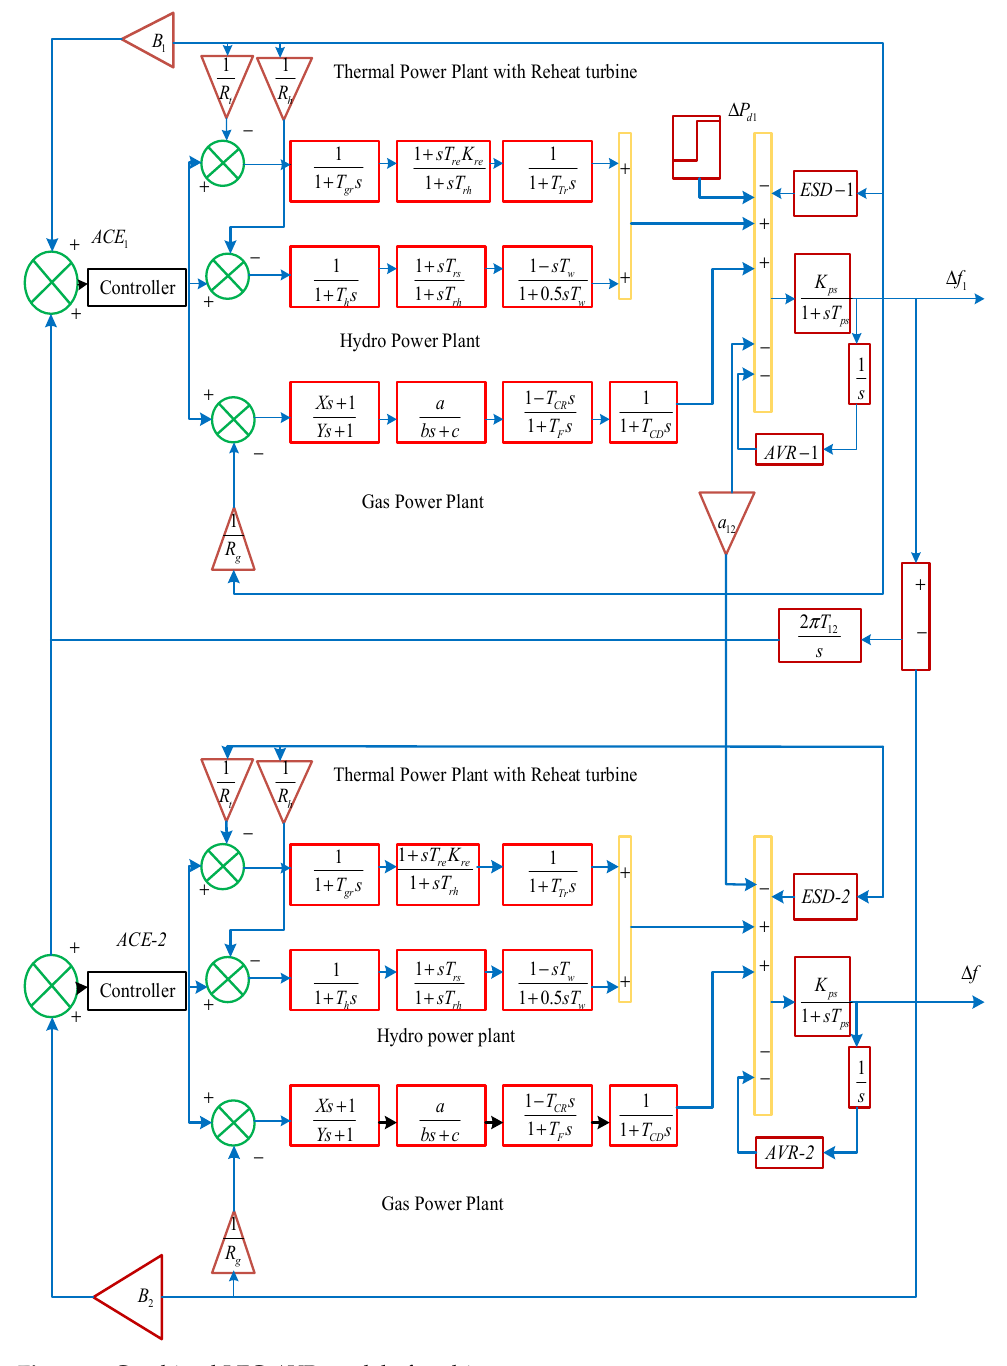
Figure 1. Combined LFC-AVR model of multi-area system.